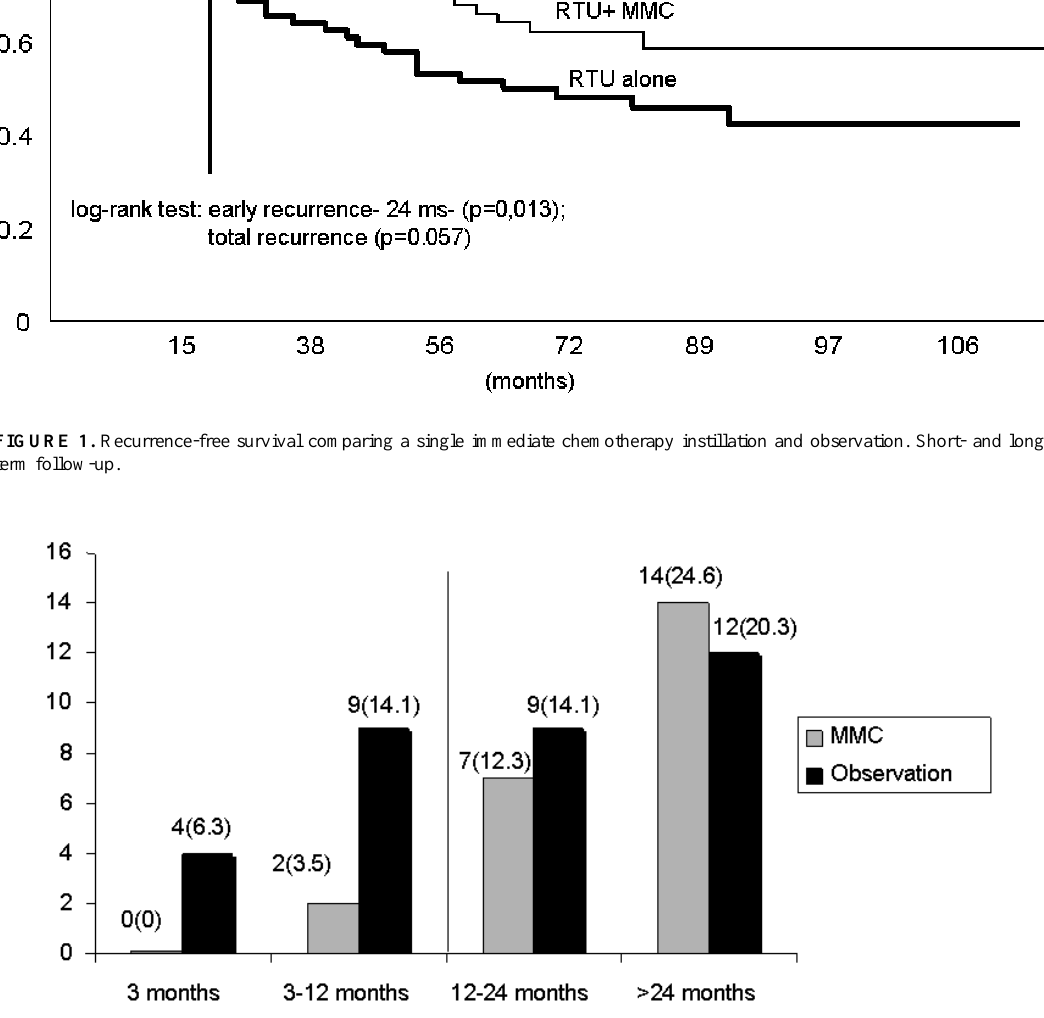
FIGURE 2. Recurrence percentage comparing a single immediate chemotherapy instillation and observation. Time of